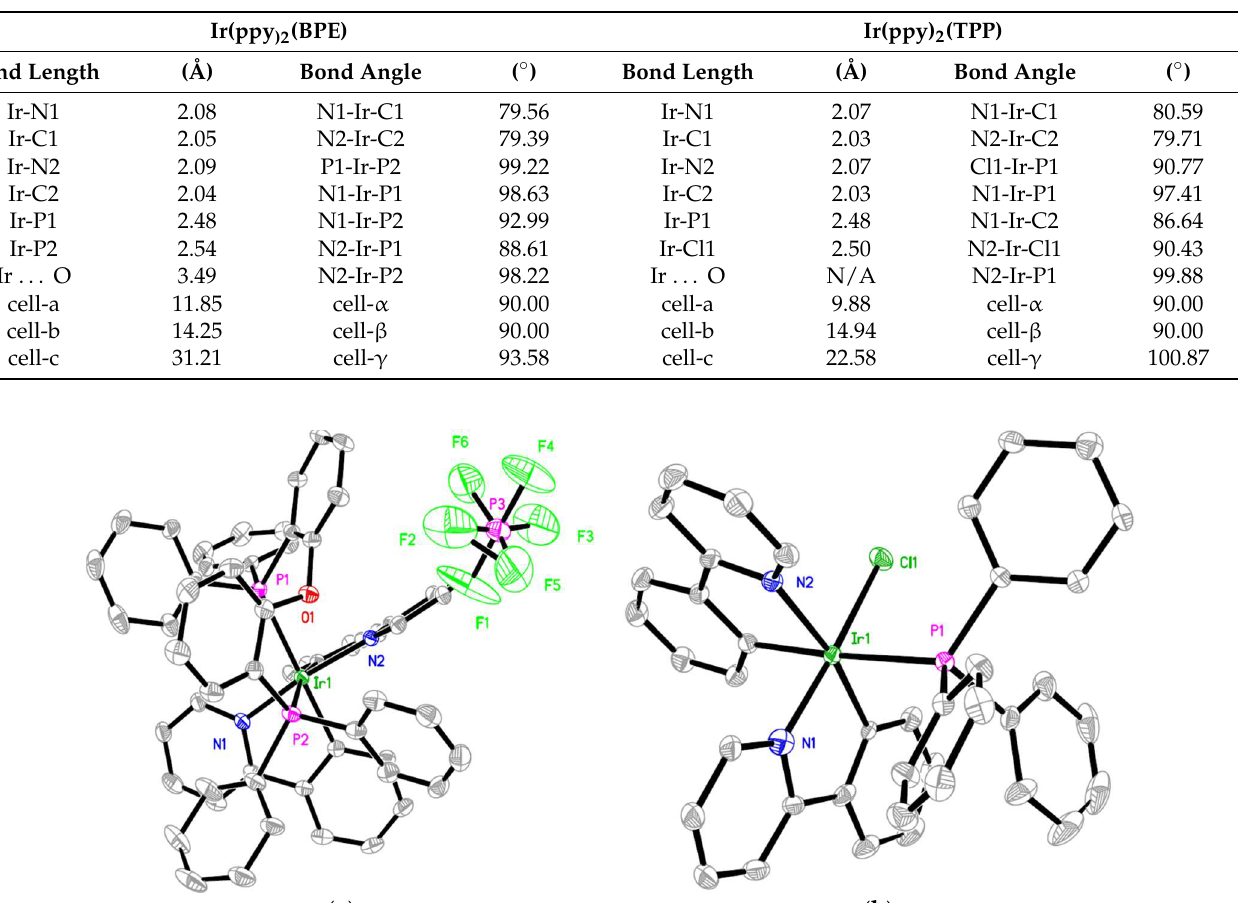
Table 1. Selected geometric parameters of Ir(ppy) 2 (BPE) and Ir(ppy) 2 (TPP).